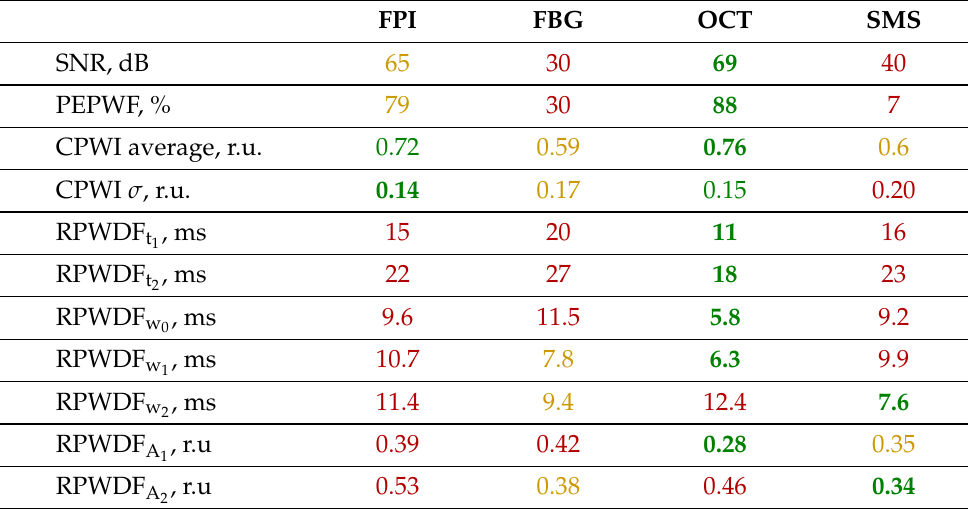
Figure 7. Fragment of PW signal measured at radial artery of Subject II with SMS sensor during sensor cooling. ( a ) raw signal, ( b ) high-pass filtered signal. Table 2. Comparison of pulse wave signals measured with different sensors. Measurements were performed at the radial artery with palm movement. Best scores are shown in bold. Green text color shows the values that deviate not greater than 5% from the best score, orange text color—values which deviation from the best score is between 5% and 25%, red text color—values which deviation from the best score is greater than